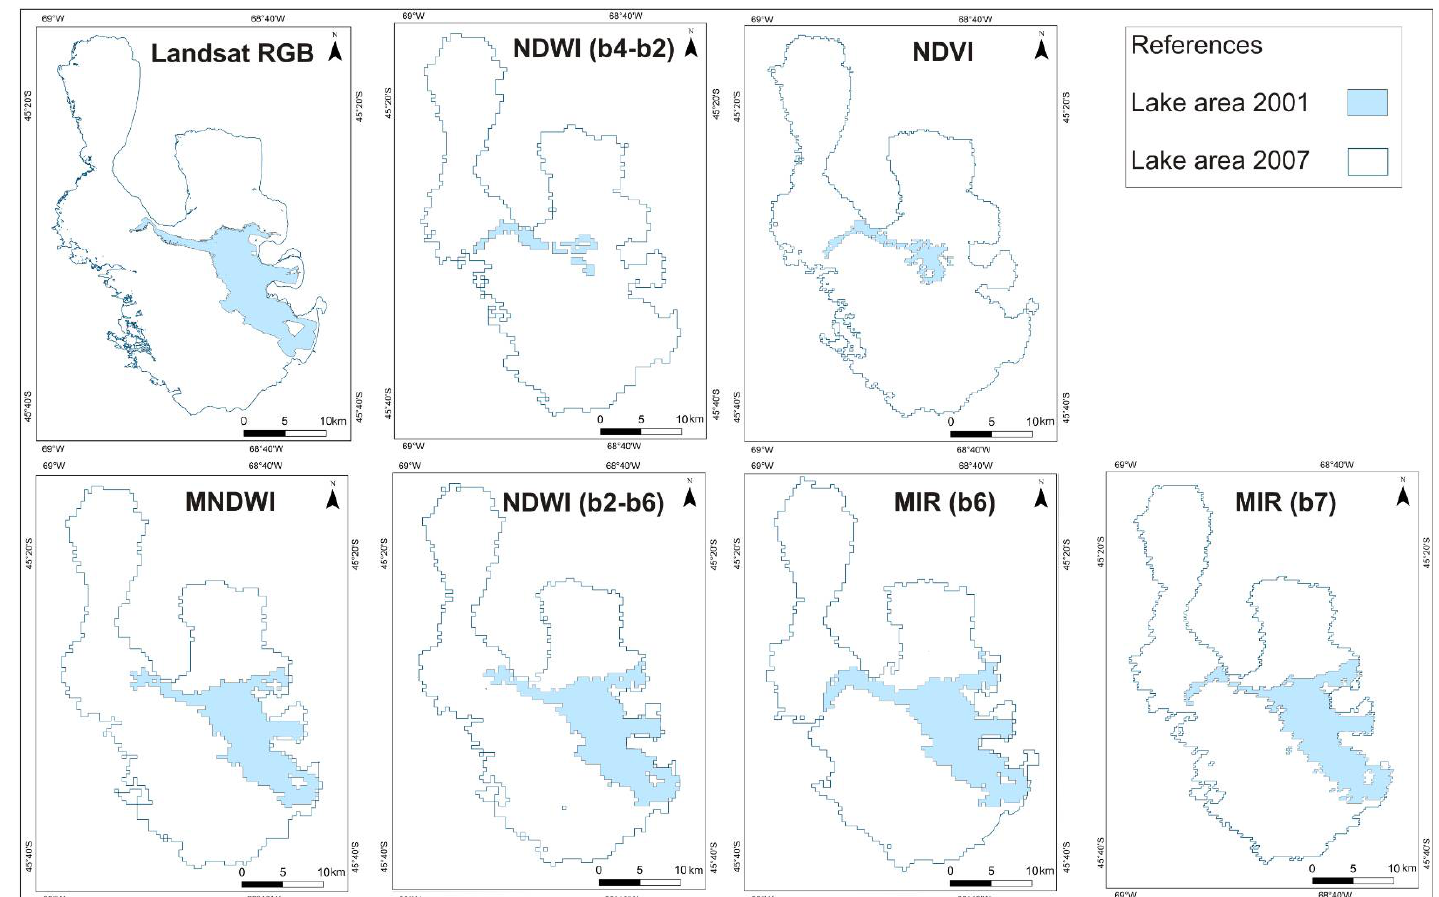
Figure 3. CH lake area calculated with Landsat and MODIS products for a year (2001) with low area extension and a year (2007) with a large area extension. On those years with low lake area extension, the Normalized Difference Vegetation Index (NDVI) and NDWI indexes produced higher errors. The errors with those indexes are probably related to the physical features of the lake. As a shallow lake soil bottom characteristics strongly influence the reflectance in the visible and near infrared domain, which are used to calculate those indexes.